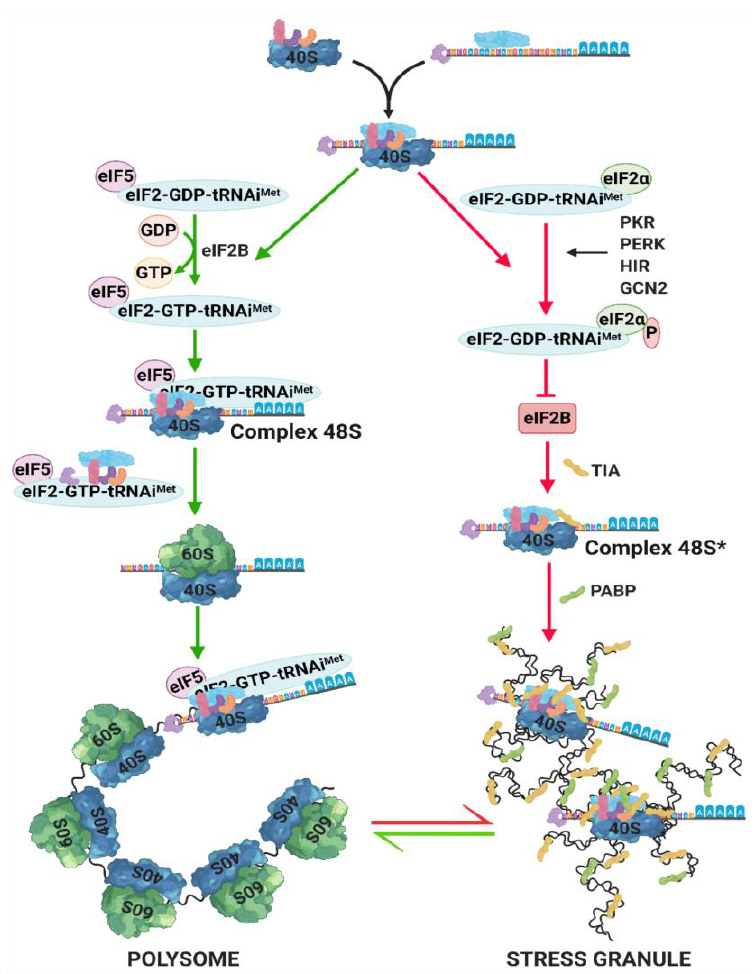
Figure 2. Translational start in presence or absence of cellular stress. In normal conditions and in absence of stress (green arrow pathway), eIF2B catalyzes the exchange of GDP to GTP and allows the coupling of the ternary complex to the 48S complex. The ribosomal subunit 60S can join the complex and the addition of more ribosomes to this complex make a polysome, which is able to translate the mRNA. Upon cellular stress (red arrow pathway), eIF2 α is phosphorylated by stress sensor kinases and inhibits eIF2B, precluding the binding to EIF5. The ternary complex generates a 48S* complex instead, which is deficient in eIF2 / eIF5 and unable to start the translation. This complex recruits TIA-1 and TIAR proteins to form the SGs. Additionally, SGs recruit more RNA binding proteins, such as PABP. mRNAs move in and out of SGs depending on the cellular translational requirements. Thus, SGs are highly dynamic complexes, in equilibrium with polysomes.